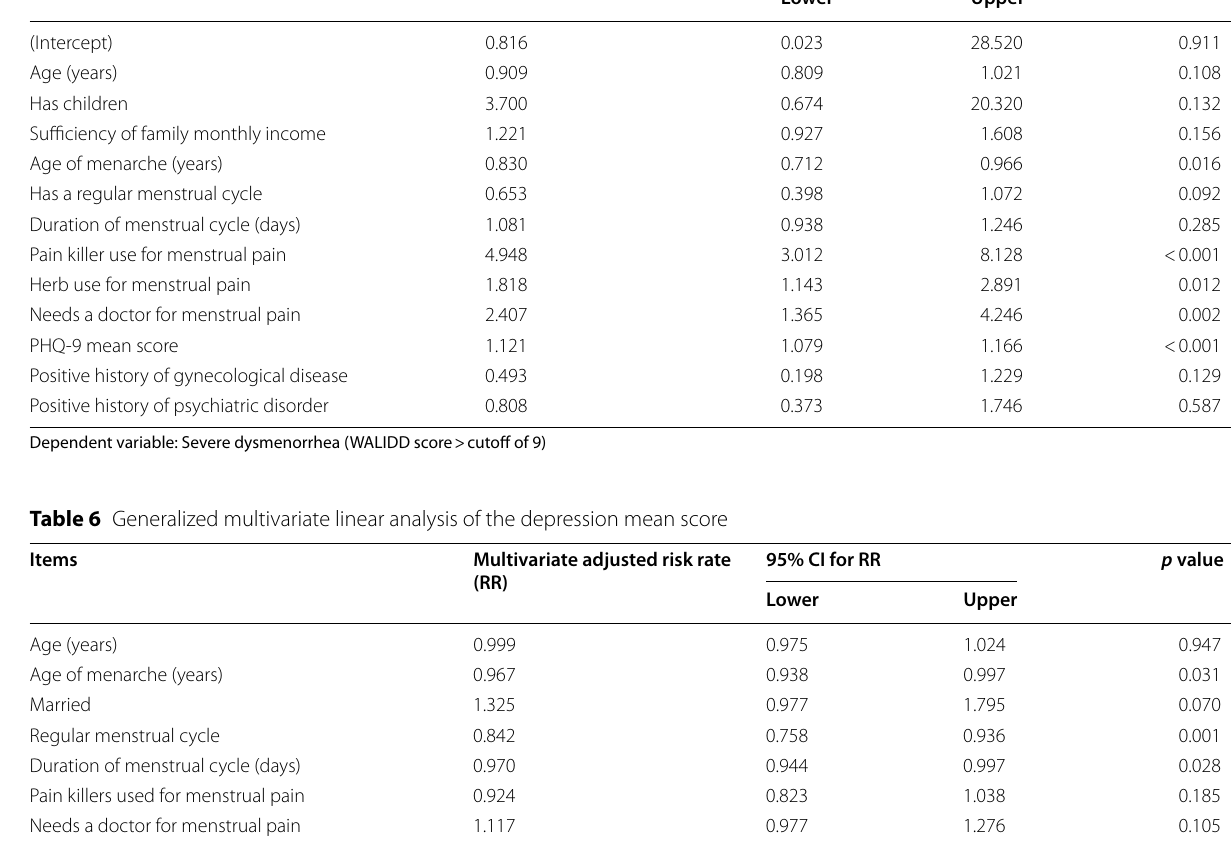
Table 5 Multivariate binary logistic regression analysis of the students’ odds of severe dysmenorrhea